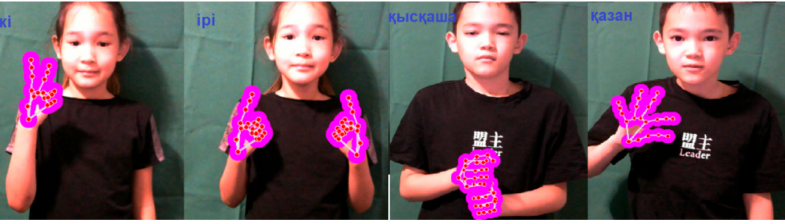
Figure 3. Direction of movement (straight, intermittent, jumping, repetitive).